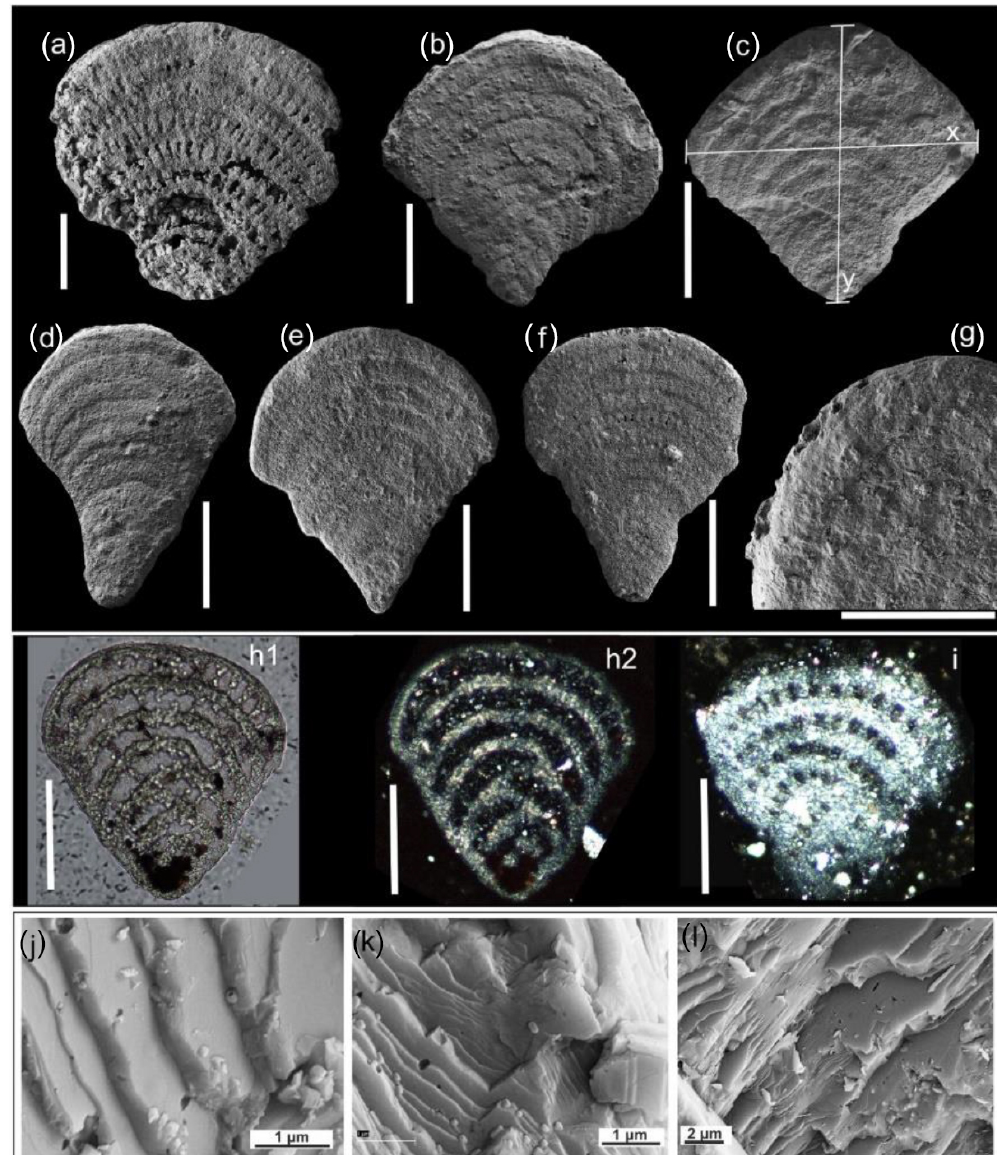
Figure 1. Images of Semitextularia Miller and Carmer (1933) specimens: (a–g) SEM images of the Semitextularia tests; (h) internal test texture in a conventional-light microscope image (h1) and using polarized-light microscopy (h2) ; (i) image of Semitextularia thin section showing transparent test ( a–i ; scale bars are equal to 100µm); (j–l) SEM images showing foliated structure of the test wall. (a) Miłoszów, sam- ple B1, MWGUW ZI/67/MG7.02. (b) Miłoszów, sample 11, MWGUW ZI/67/MG5.03. (c) Miłoszów, sample 11, MWGUW ZI/67/MG5.04. (d) Miłoszów, sample 12, MWGUW ZI/67/MG5.30. (h) Miłoszów, sample 12, MWGUW ZI/67/MG5.27. (i) Miłoszów, sample MO, MWGUW ZI/67/MG5.40. (j) Miłoszów, sample 12R, MWGUW ZI/67/MG9.23. In panel (c) , x indicates test height (i.e., maximum di- ameter) while y is test